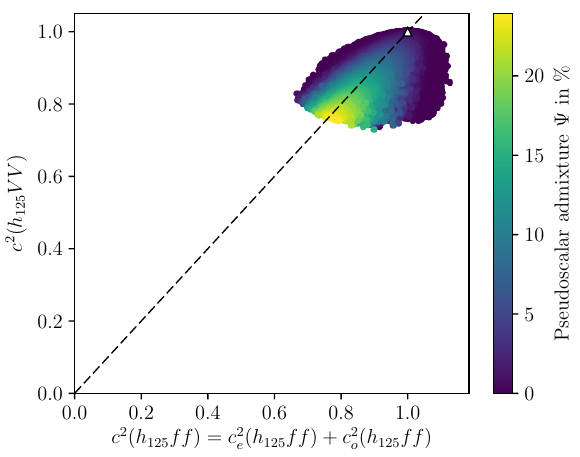
Figure 5 . C2HDM type I: pseudoscalar admixture (cid:9) C2HDM of h 125 as a function of the e(cid:11)ective couplings squared. The white triangle denotes the SM value. The dashed line represents equal scaling of the